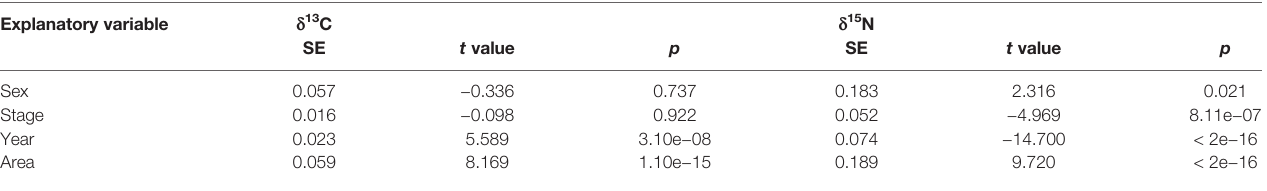
TABLE 2 | Statistical outputs of generalized linear model in d 13 C and d 15 N for D. gigas